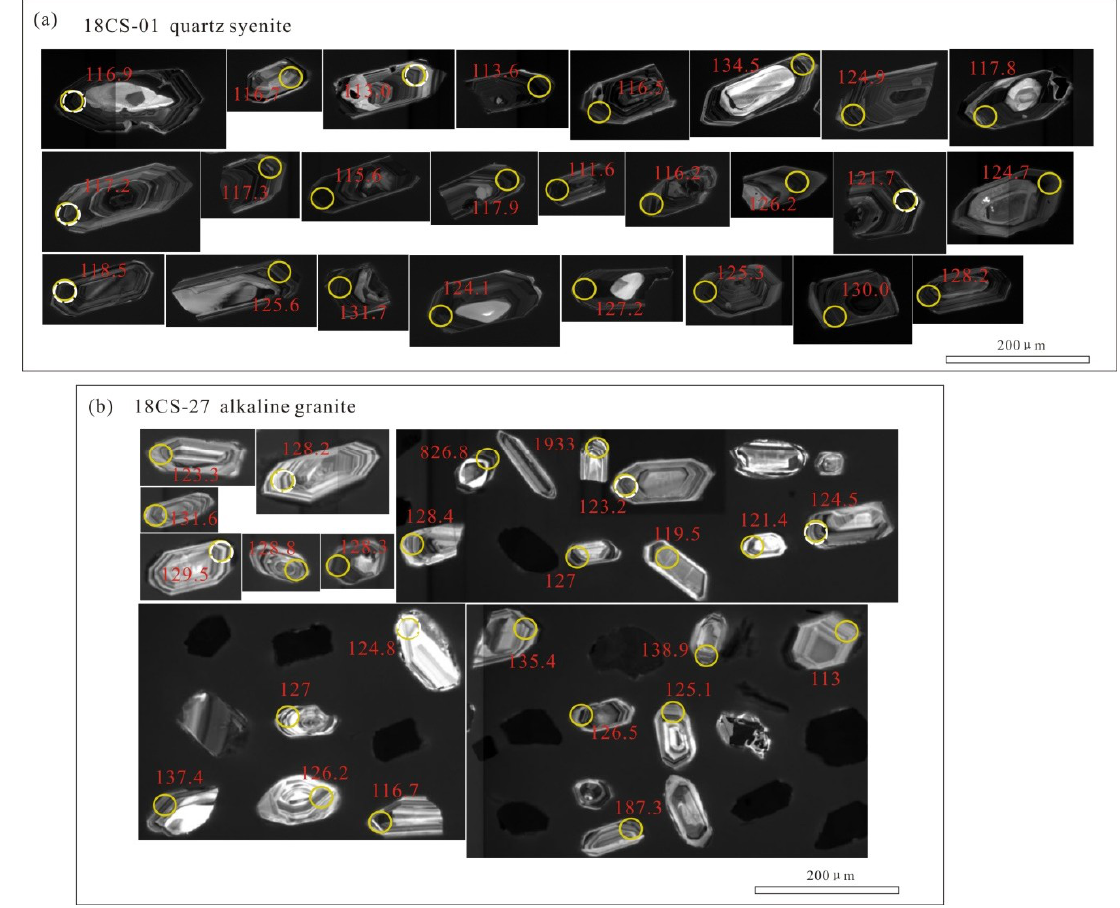
Figure 6. Zircon cathode luminescence (CL) diagram of the Chishan alkaline complex. ( a ) is the CL of quartz syenite (18CS-01); ( b ) is the CL of alkali granite (18CS-27).